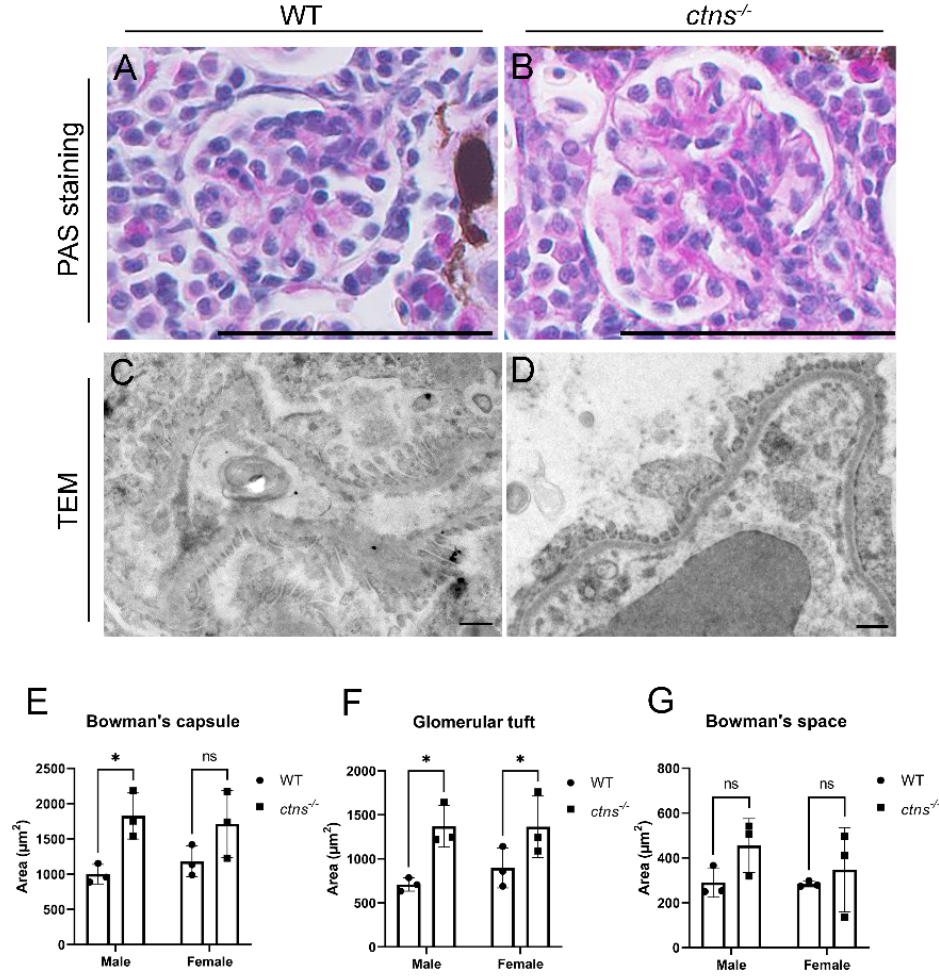
Figure 4. Glomerular morphology in wild-type and in ctns − / − zebrafish. ( A , B ) Representative images of the glomerulus of wild-type ( A ) and ctns − / − ( B ) 18-month-old zebrafish. PAS staining. The scale bars represent 50 µ m. ( C , D ) Representative TEM images of the glomerulus of wild-type ( C ) and ctns − / − ( D ) zebrafish. The scale bars represent 1 µ m. ( E – G ) The quantification of the surface areas of Bowman’s capsule ( E ), glomerular tuft ( F ), and Bowman’s space ( G ) of wild-type and ctns − / − zebrafish in both genders. Each dot represents one zebrafish, for a total of n = 3 wild-type and n = 3 ctns − / − 18-month-old zebrafish. Two-way ANOVA with Fisher’s least significant difference (PLSD) test: * p < 0.05; ns: not